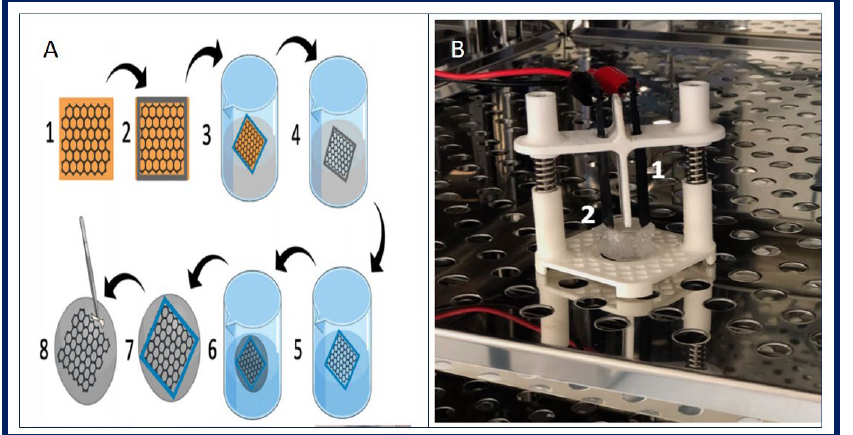
Figure 18. ( A ): fabrication of biocomposite. (1) Graphene layer on copper foil. (2) PDMS frame ad- justed to desired biomaterial shape. (3) Etching Cu foil by ammonium persulfate solution. (4) Float- ing graphene layer in PDMS frame. (5) Washing out ammonium persulfate. (6) Fishing graphene layer posited in PDMS frame with Am. (7) Graphene placed on Am surface. (8) Carful mechanical